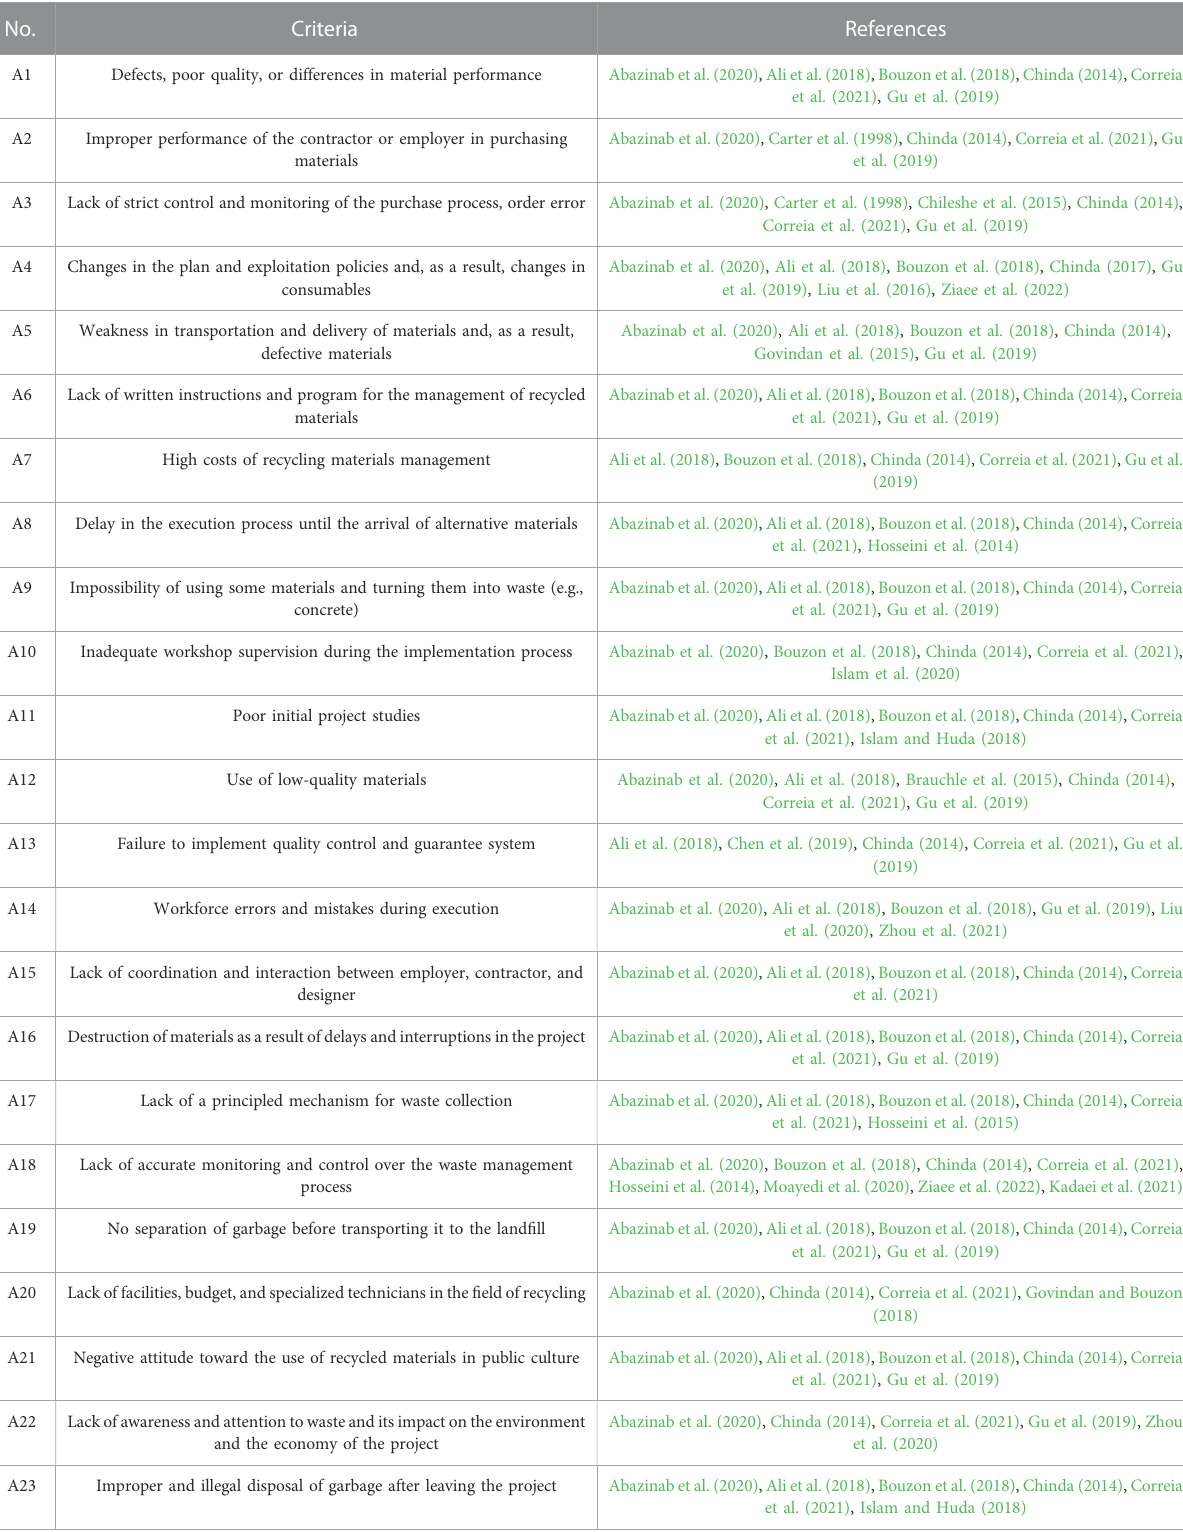
TABLE 1 Challenges of RL implementation to achieve sustainability in the construction industry (Source: